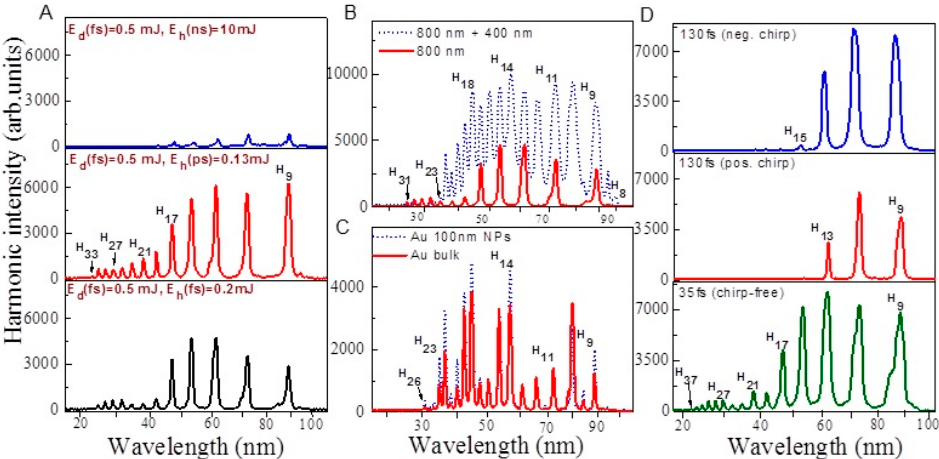
Figure 5. Harmonics spectra from the plasma of bulk Au. ( A ) single-color driving pulses (800 nm) and di ff erent pulse durations of heating pulses, ( B ) single- and two-color (800 + 400 nm) driving pulses while using 0.2 mJ femtosecond heating pulses, ( C ) TCP of ablated bulk Au and Au 100 nm NPs, and ( D ) application of chirped laser